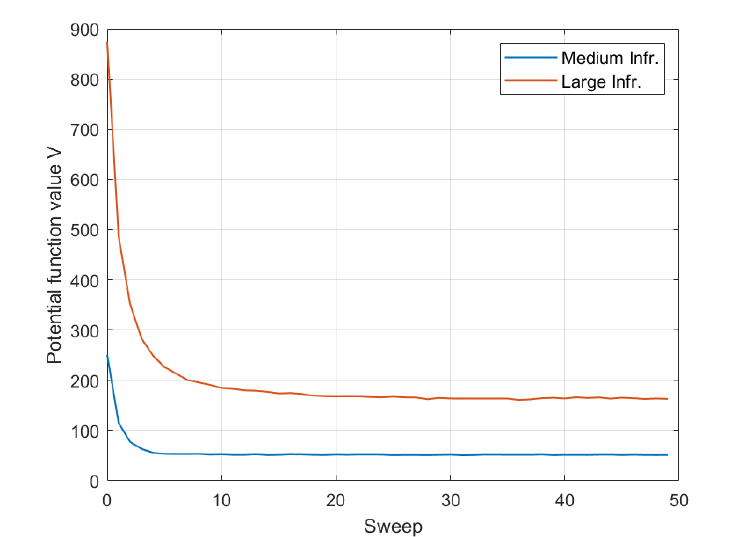
Figure 8. MRF-based workload redistribution